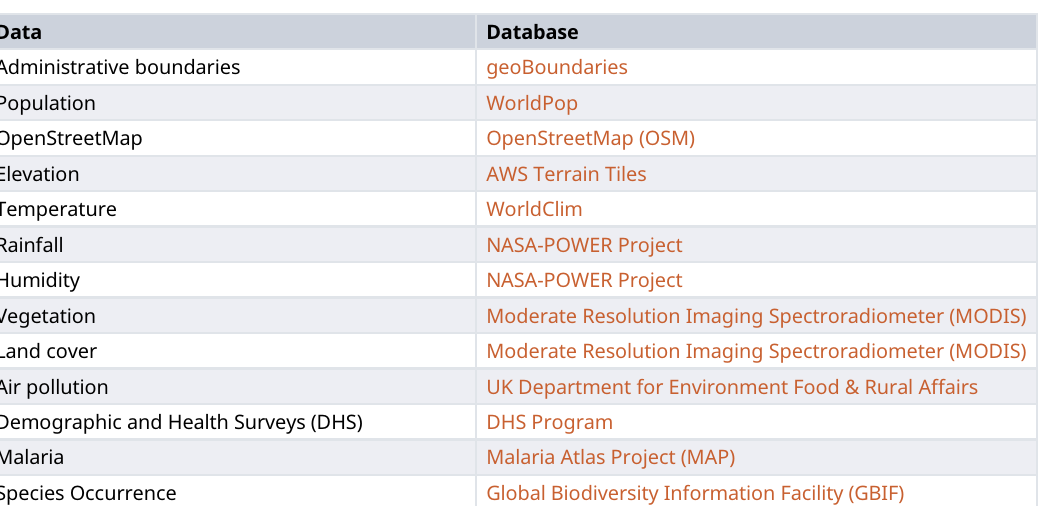
Table 2. Databases included in the rspatialdata